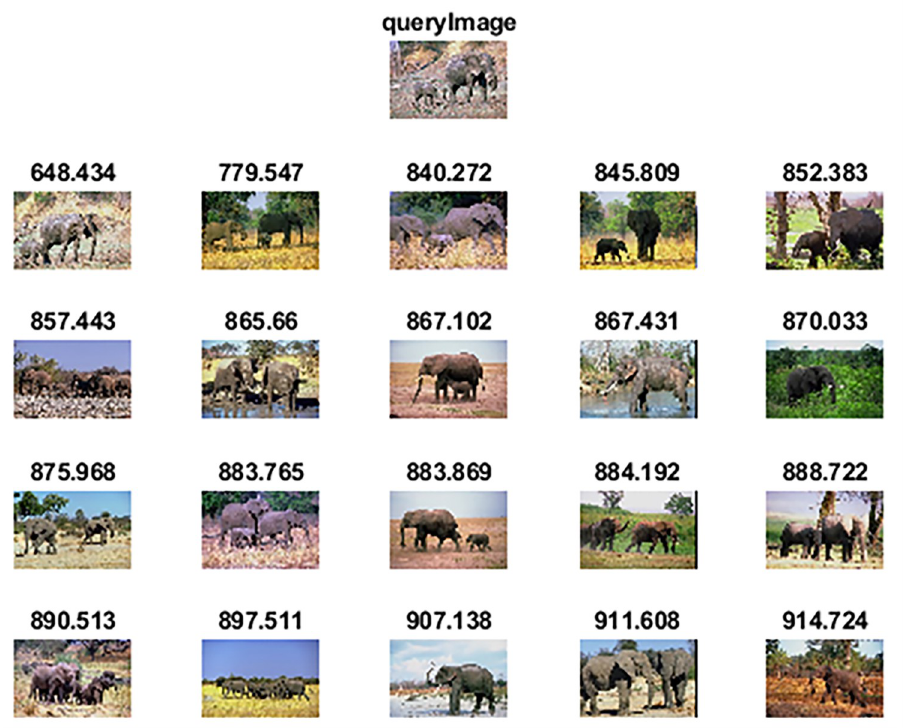
Fig 8. Top-20 retrieved images against query image (class: Elephants) (reprinted from [3] under a CC BY license, with permission from J. Z. WANG, original copyright [2003]).